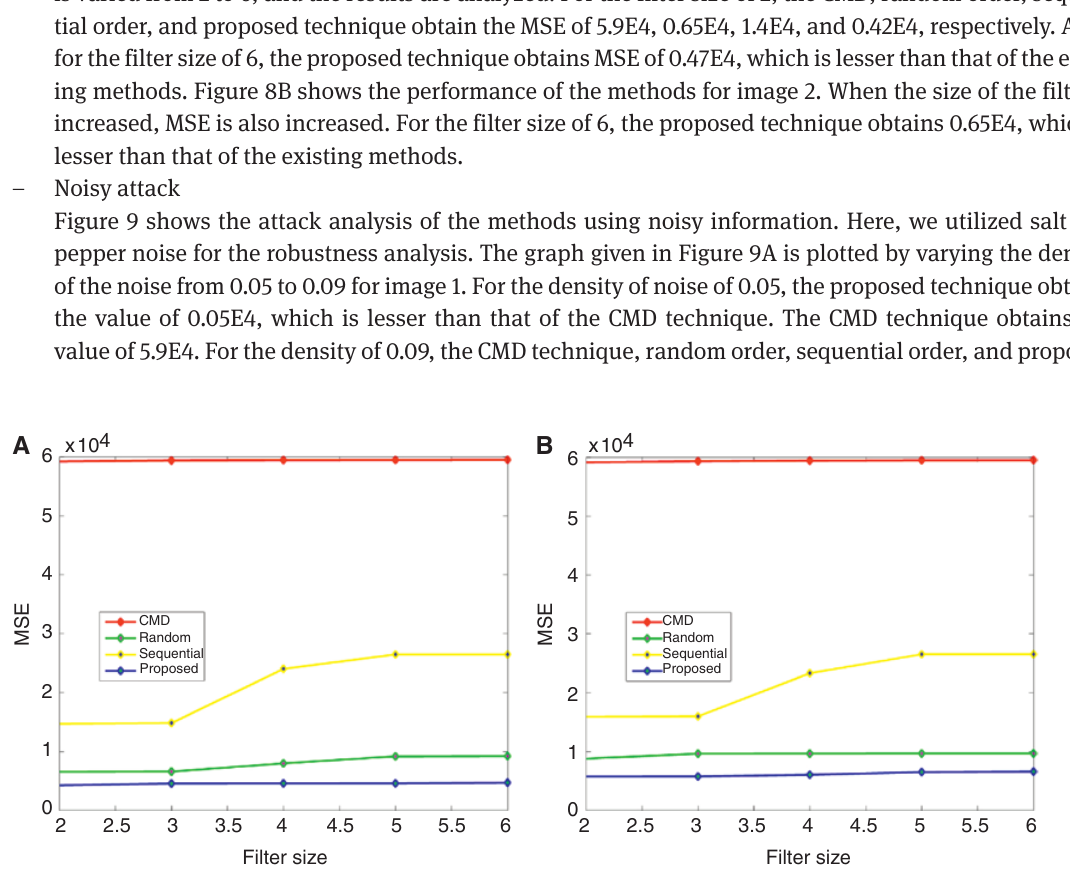
Figure 8: MSE after Filtering Attack.